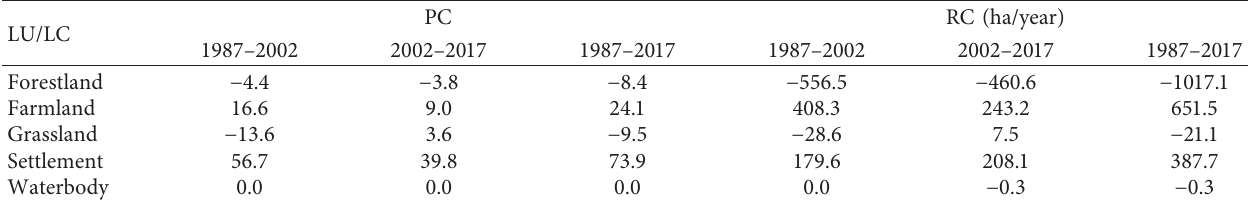
Table 6: Percentage and rate of changes occurred in MFBR from 1987 to 2017 periods.